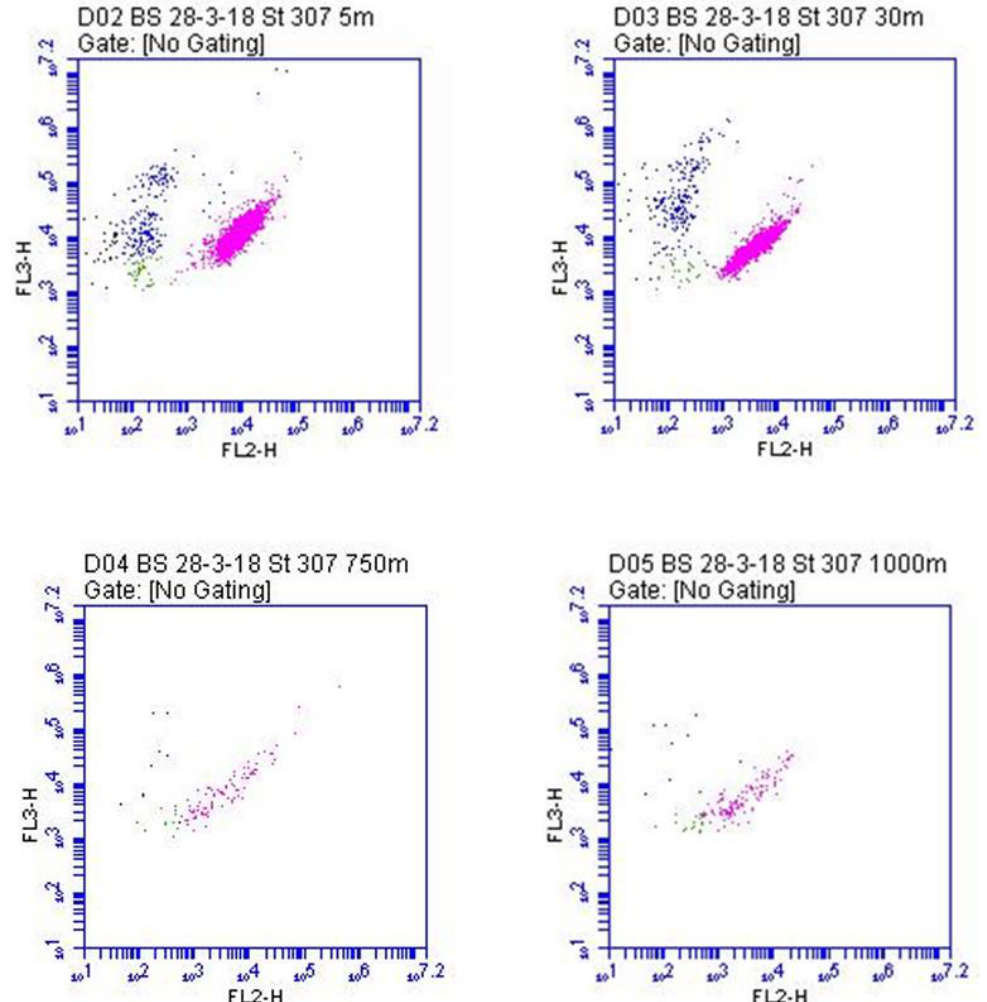
Figure 6. Cytograms of samples from different depths of the Black Sea (for methods, refer to [12]), (Cytometer Accuri C6, Becton Dickinson, Oxford, UK). In the density plots the pink dots are the picocyanobacteria. Orange fluorescence: FL2 channel = 585/40 nm and red fluorescence: FL3 channel > 670 nm.